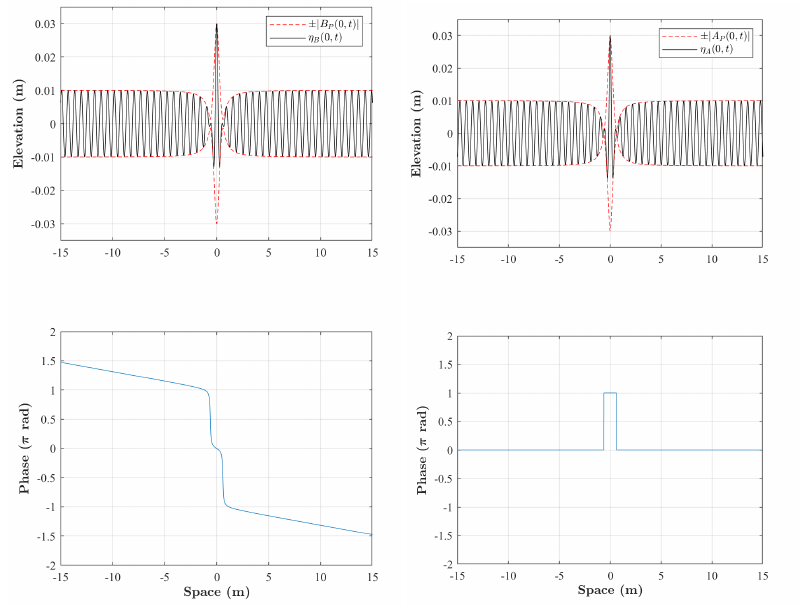
Figure 2. Theoretical spatial surface elevation profiles (solid black lines), wave envelope (dashed red lines) and the corresponding phase (blue lines) of the Peregrine breather at its peak time t = 0 s from time-NLSE ( left ) and space-NLSE ( right